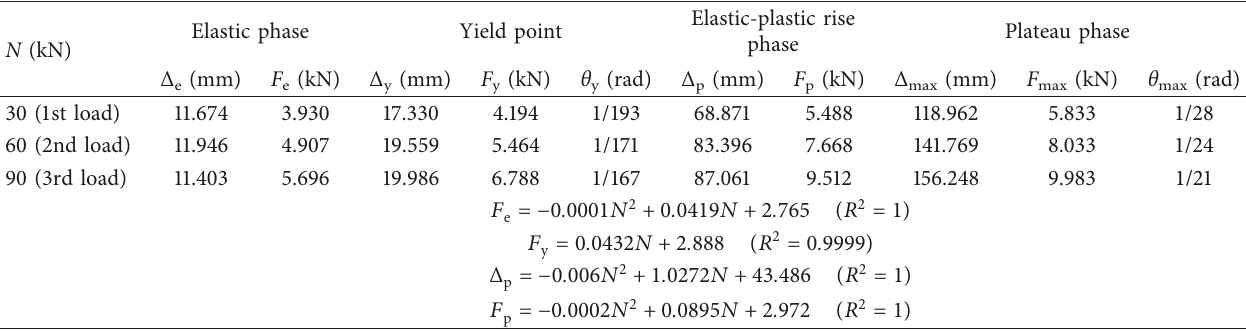
Table 3: The basic parameters of the three-phase linear model.